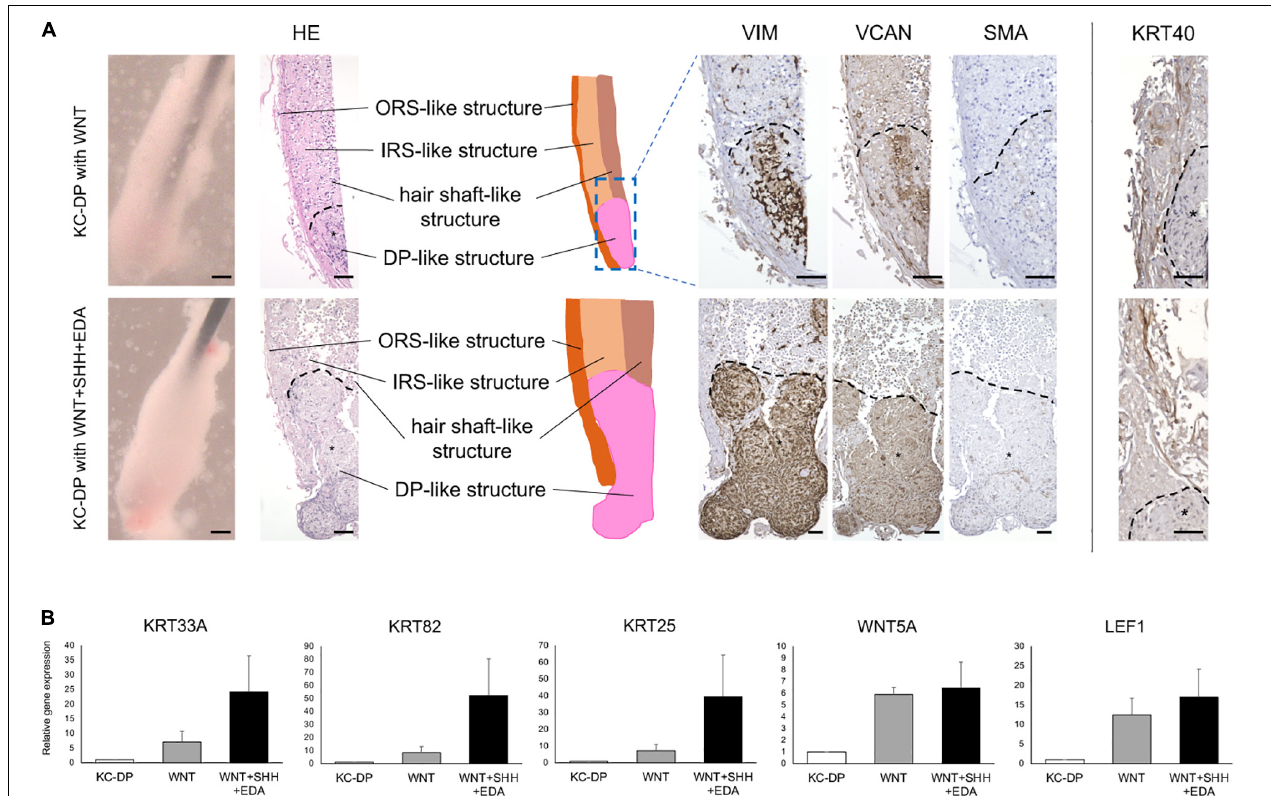
FIGURE 3 | Activation of WNT, SHH, and EDA signaling improved HF-related marker expression in KC-DP constructs. (A) Addition of the activators of signaling pathways involved in HF morphogenesis did not evidently ameliorate immunohistochemically detected HF marker expression in KC-DP constructs. *DP aggregates. (B) HF-related gene expression levels analyzed by qRT-PCR in KC-DP constructs tended to be increased by a WNT agonist (WNT) treatment, which tended to be further enhanced by the treatment by the mixture of agonists (WNT + SHH + EDA) (Mean ± SEM; n = 3, triplicate for each experimentation; Wilcoxon signed-rank test). KC, keratinocyte; DP, dermal papilla, Scale bar: 200 µ